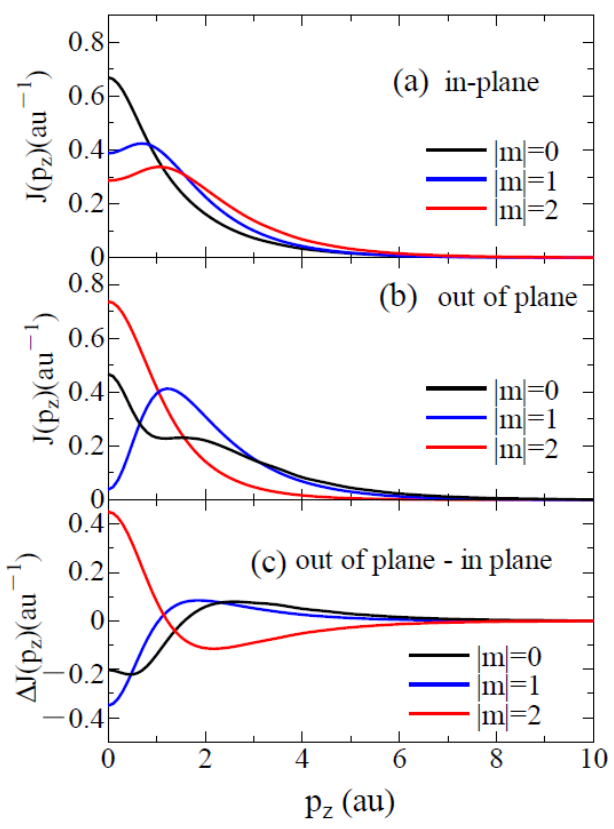
Figure 6. Model calculations of MCPs for Fe3d under the uniaxial crystal field with an applied magnetic field ( a ) parallel ( b ) perpendicular to the film plane. Anisotropies are also shown in ( c ). The model calculations are convoluted by the experimental resolution of 0.43 au. Table 2. Occupation number of magnetic quantum numbers obtained by magnetic Compton profile measurements. Notice that | m | = 1 states have two states of m = ± 1, and | m | = 2 states m = ±